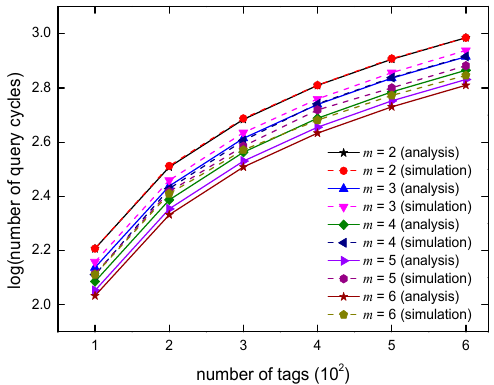
Figure 9. Comparison of simulation and analysis values.